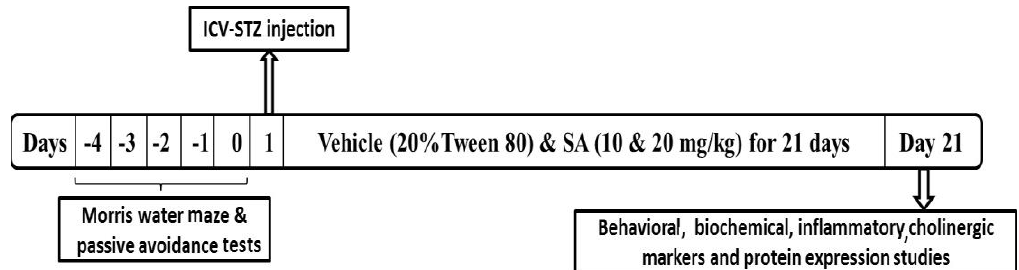
Figure 1. Schematic diagram showing experimental protocol. Morris water maze training trials were given for 4 days (−4 to −1 day) followed by retention trial on day 0. Intracerebroventricular streptozotocin was administered on day 1. Experimental rats were dosed with sinapic acid for the next 21 days. On day 21, rats were sacrificed after behavioral assessment.